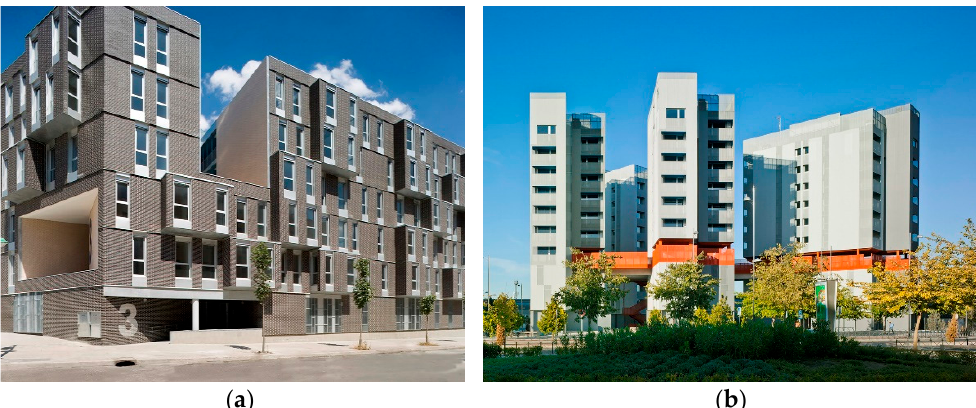
Figure 8. Public housing complex in Coslada ( a ) and public housing complex and offices, commercial premises, and parking spaces in Coslada, Madrid, Spain ( b ) by Temperaturas Extremas Office (Amann, Cánovas, Maruri). Photo: David Frutos.